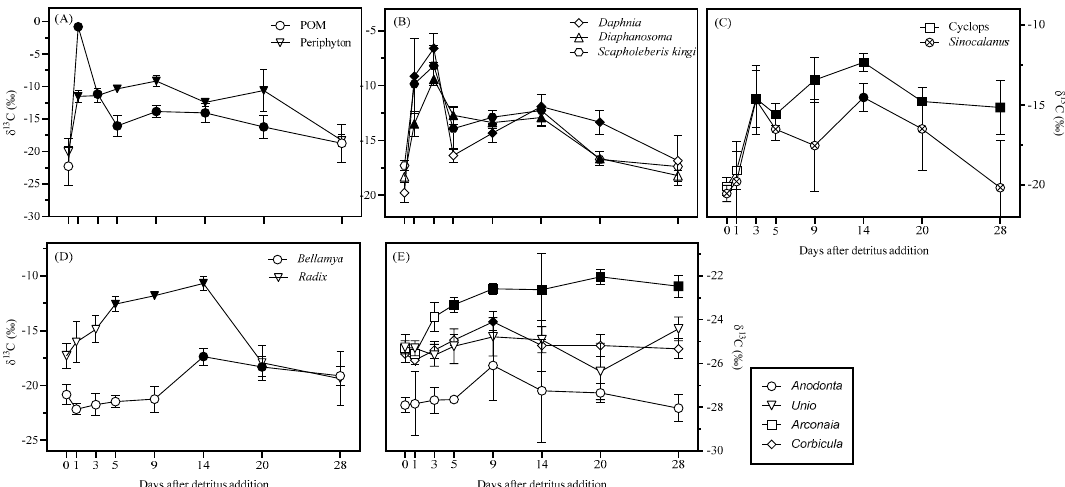
Figure 1. Variations in δ 13 C signatures of pelagic and benthic organisms following addition of labelled Microcystis detritus to the water column of the mesocosms during the 28-day experiment. Error bars represent the standard deviation (SD) for three replicate mesocosms. ( A ) Periphyton (sampled from the inside wall of the mesocosm), POM (particulate organic matter); ( B ) cladocerans ( Daphnia similis , Diaphanosoma spp. and Scapholeberis kingi ); ( C ) copepods ( Sinocalanus dorrii and cyclopoid copepods); ( D ) snails ( Radix swinhoei and Bellamya aeruginosa ) and ( E ) bivalves ( Anodonta woodiana , Unio douglasiae , Arconaia lanceolata and Corbicula fluminea ). Note the di ff erent scales on the y-axes. The filled symbols represent the δ 13 C of a given species on days where it was significantly di ff erent from the control’s values (on day 0).